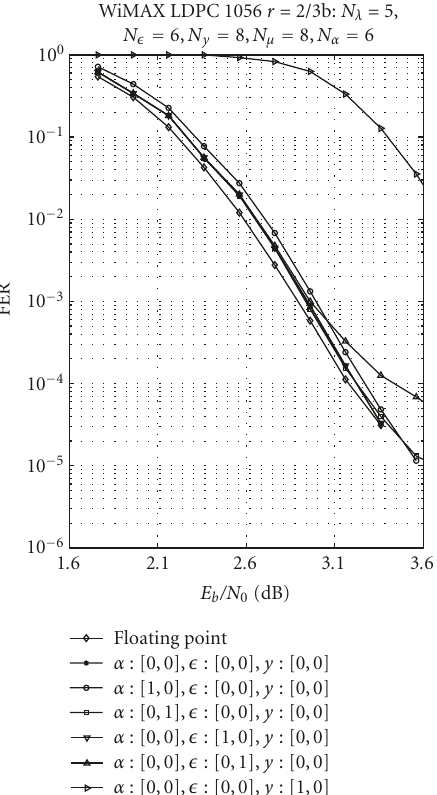
Figure 18: WiMAX LDPC code: e ff ects of saturation and trunca- tion before